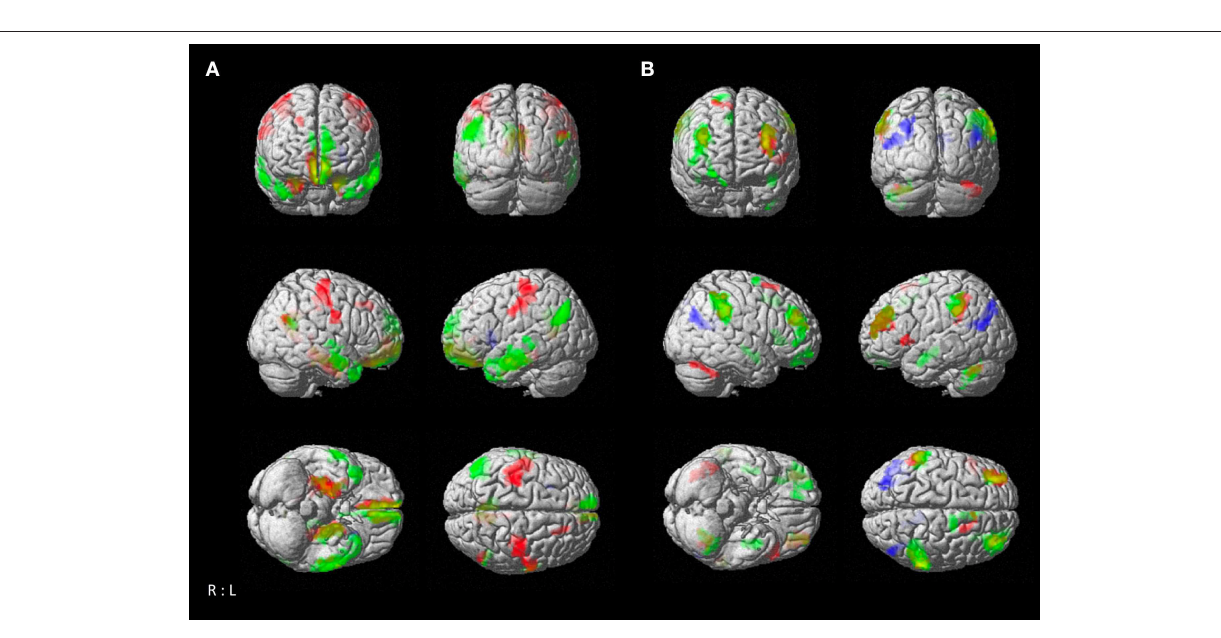
FIGURE 4 | Resting-state connectivity correlation of atrophy seeds with age. (A) Negative correlation between age and brain-wide resting-state connectivity of seeds ( green : left temporal seed; red : right temporal seed; blue : parietal seed). (B) Positive correlation between age and brain-wide resting-state connectivity of seeds with age [color coding as in (A) ]. Results are cluster-level FWE corrected at p < 0.05 ( p < 0.001 at